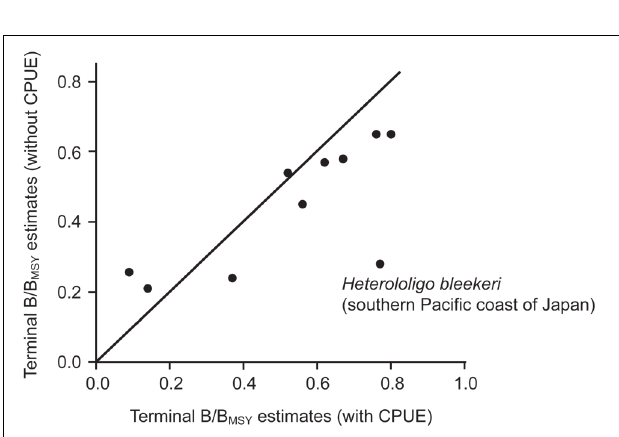
FIGURE 4 | Terminal B/B MSY estimates of 10 stocks without (CMSY) and with (BSM) CPUE data added to the analysis.